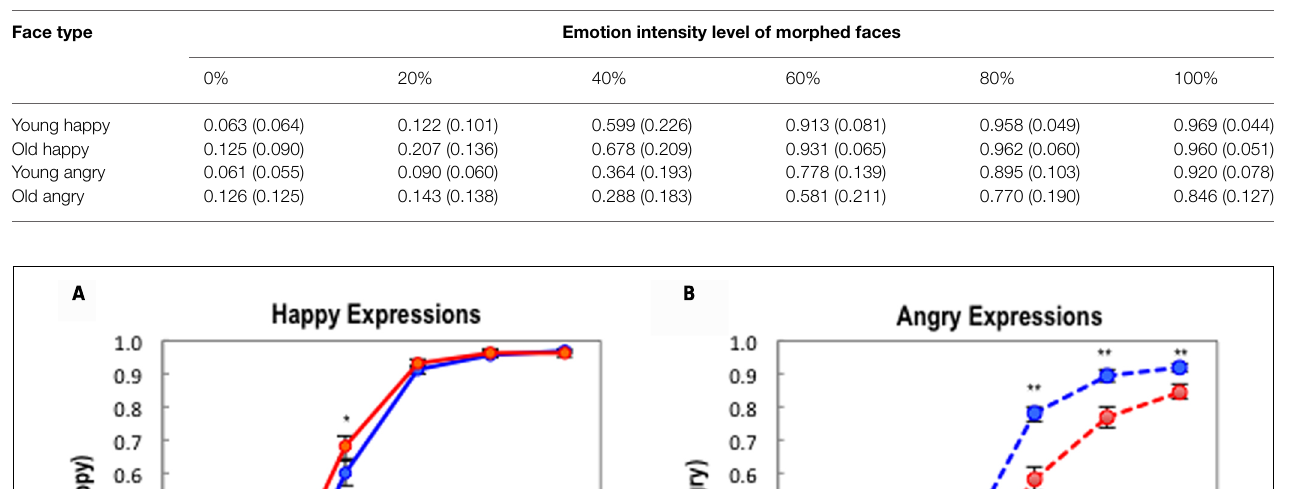
FIGURE 4 | (A) Probabilities of happy decisions as a function of emotion intensity and facial age. (B) Probabilities of angry decisions as a function of emotion intensity and facial age. (C) Response times of happy